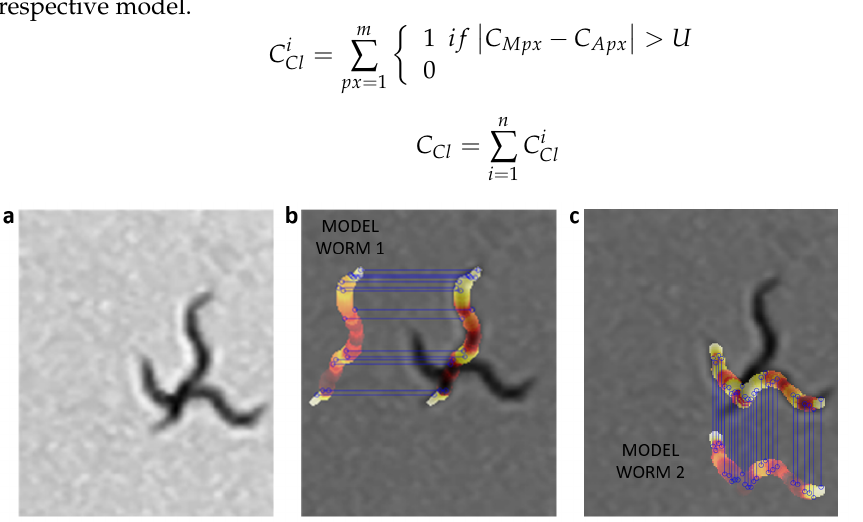
Figure 9. Color criterion evaluation. For each possible skeleton, its color values are obtained using the current grayscale image, and with those color values and the width values of the model, each worm is reconstructed and compared with the reconstruction of the model (model worm). The gray values were changed for a HOT color map in order to better visualize them. The blue lines indicate those pixels different from the model. ( a ) Grayscale image. ( b ) Comparison of worm1 model with current prediction of worm1. ( c ) Comparison of worm2 model with current prediction of